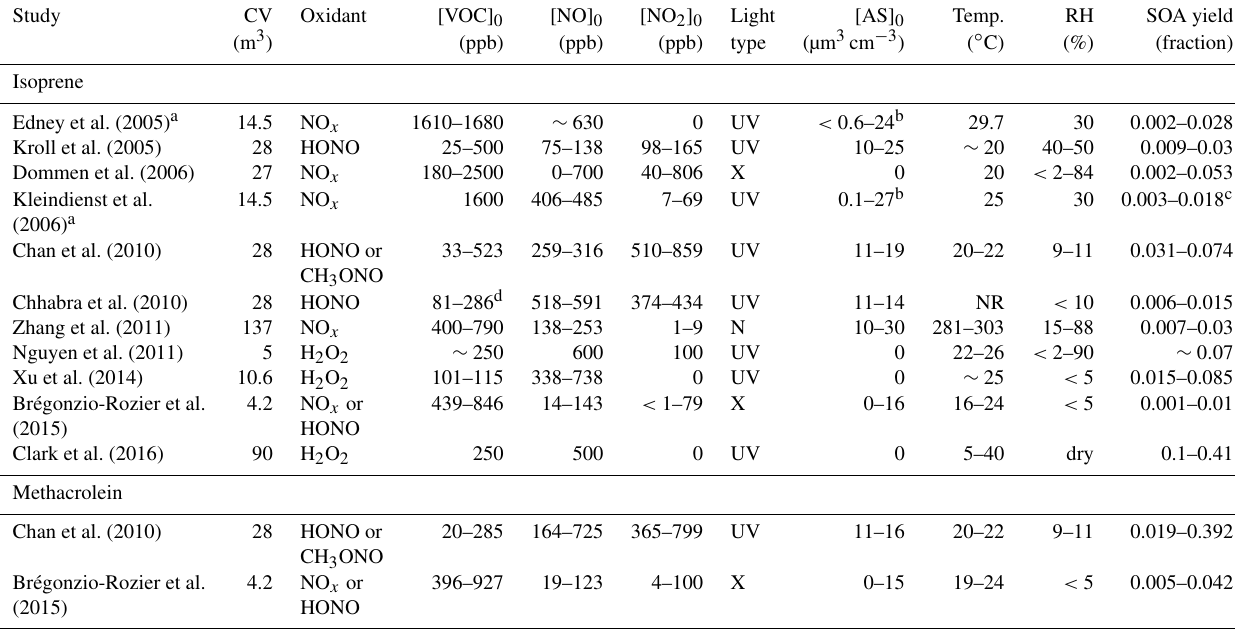
Table 2. Reported SOA mass yields and chamber conditions for isoprene and methacrolein OH-initiated oxidation under high-NO x condi-